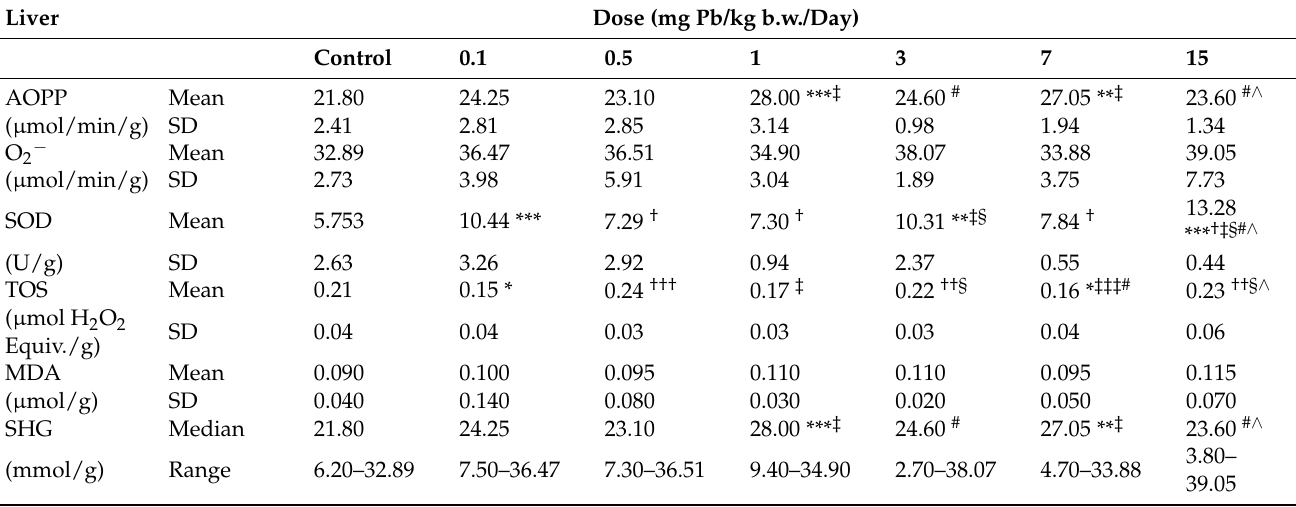
Table 3. Oxidative status in the liver and kidney tissue of Wistar rats subacutely exposed to low levels of